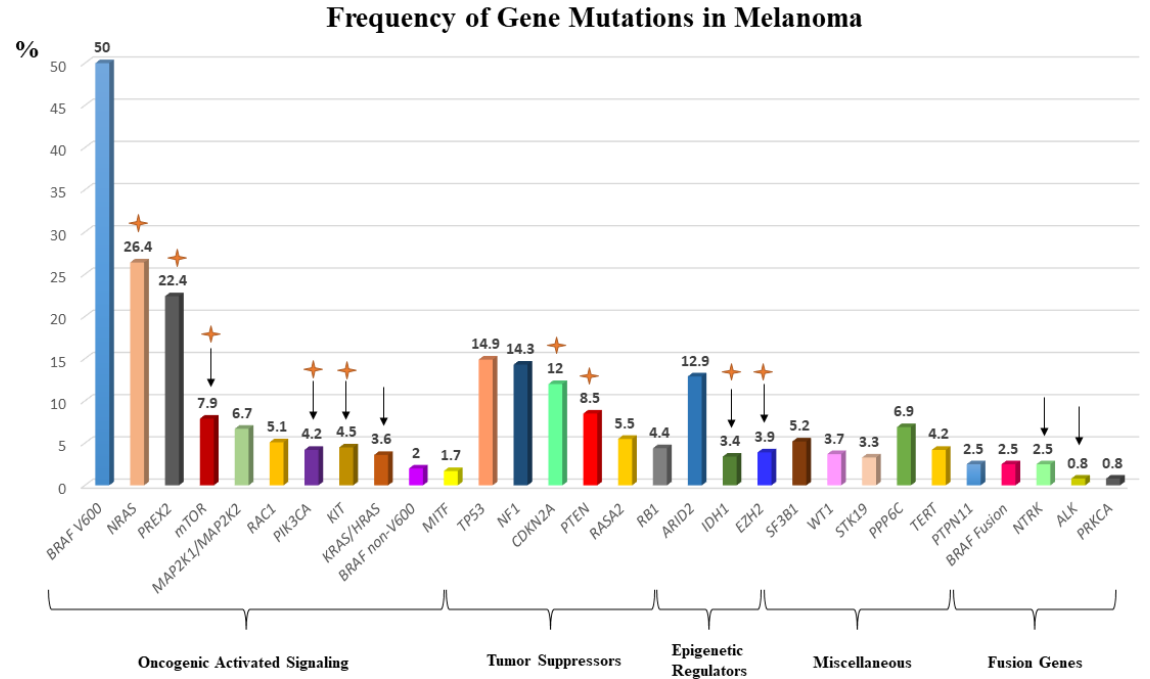
Figure 3. Frequency of common somatic mutations in melanomas are estimated based on Vanni et al.’s analysis of the frequency of somatic mutations from different studies [33]. Fusion gene frequencies were obtained from non-TCGA database, and the frequency varies among different studies. Arrows indicate the presence of FDA-approved inhibitors in cancers harboring mutations for the specific gene in non-melanoma cancers. Orange asterisks indicate the presence of ongoing trials in melanoma patients with mutation-specific alterations or melanoma patients receiving targeted therapy for the specific mutant gene. TCGA: the cancer genome atlas; FDA: food and drug administration.